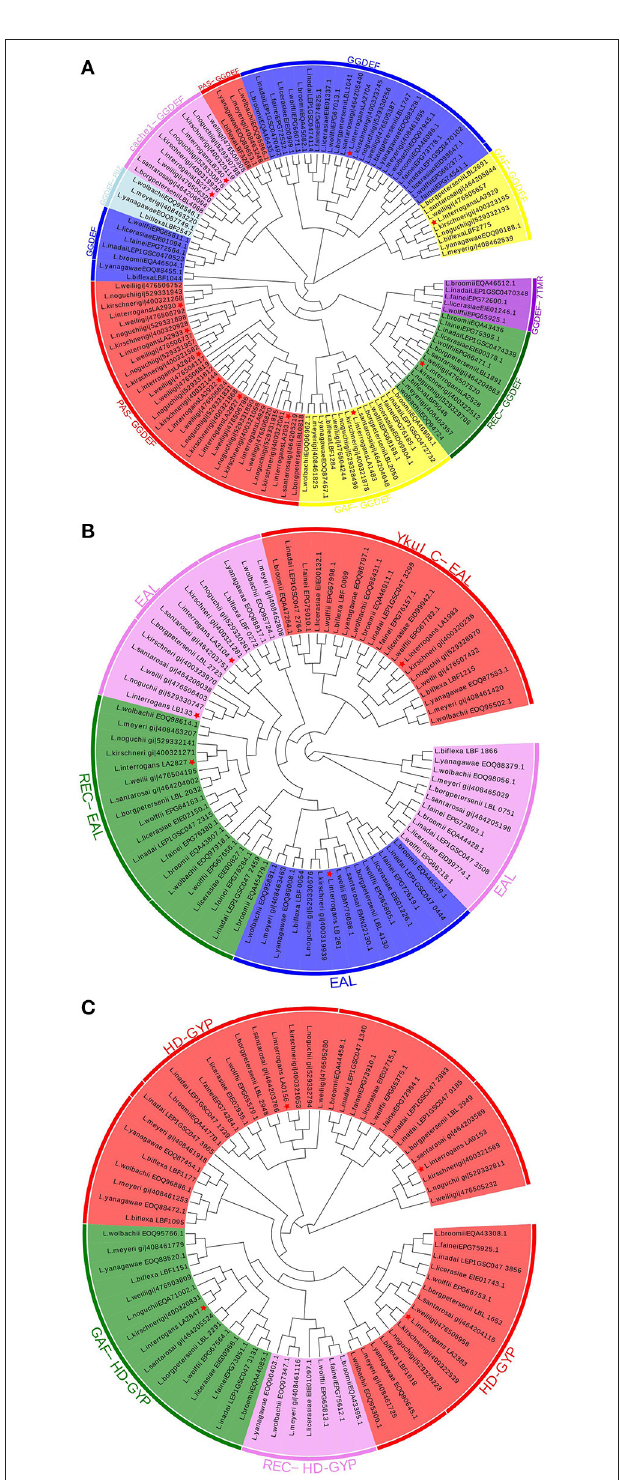
FIGURE 2 | Conserved and unique C-di-GMP metabolic enzymes are widely distributed among pathogenic and saprophytic leptospiral species. Graphic representation of phylogenetic trees from 15 leptospiral species generated with aligned sequence of (A) GGDEF, (B) EAL, and (C) HD-GYP containing proteins. Protein architectures were written outside of circles, identical protein structures are marked by same colors. Proteins from L. interrogans are indicated by red